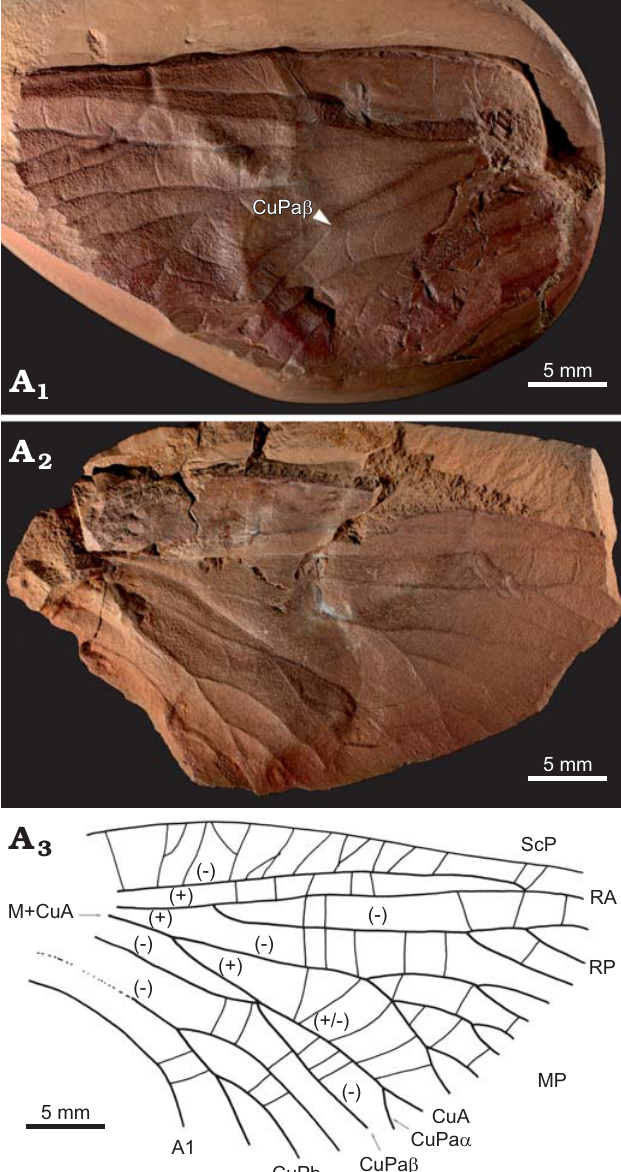
Fig. 2. Forewing venation of archaeorthopteran insect Owadpteron dareki sp. nov., holotype (MP ISEA I − F/MP/1488/26a,b/08), Carboniferous, Pen- sylvannian, Langsettian (Westphalian A), Sosnowiec-Klimontów, Upper Silesian Coal Basin, Poland. Photograph of imprint (A 1 ) and counterimprint (A 2 ), and explanatory drawing (A 3 ). Abbreviations: (+), convex vein; (-), concave vein; A1, first anal vein; CuA, cubital anterior; CuPa/b, anterior/ posterior branch of cubital posterior; CuPa α / β , cubital anterior/posterior branch of CuPa; M, media; MP, media posterior; RA/P, radius anterior/pos- terior; ScP, subcosta Diagnosis .—Based on fore-wing venation: broad costal area, RP ending with at least three branches, long stem of M+CuA; MP pectinate, each branch with secondary level branching; area between MP and CuA+CuPa α very broad at widest part and comparable to costal area; point connection of free part of CuA and CuPa; CuPa divides into branch CuPa α continuously attached to CuA and well separated